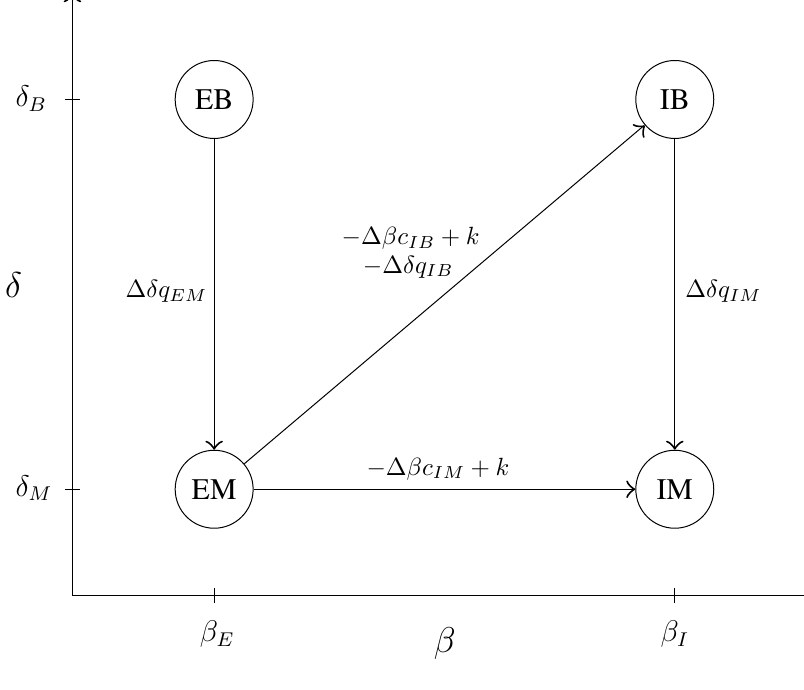
Figure 6. Incentive constraints that are binding in Case